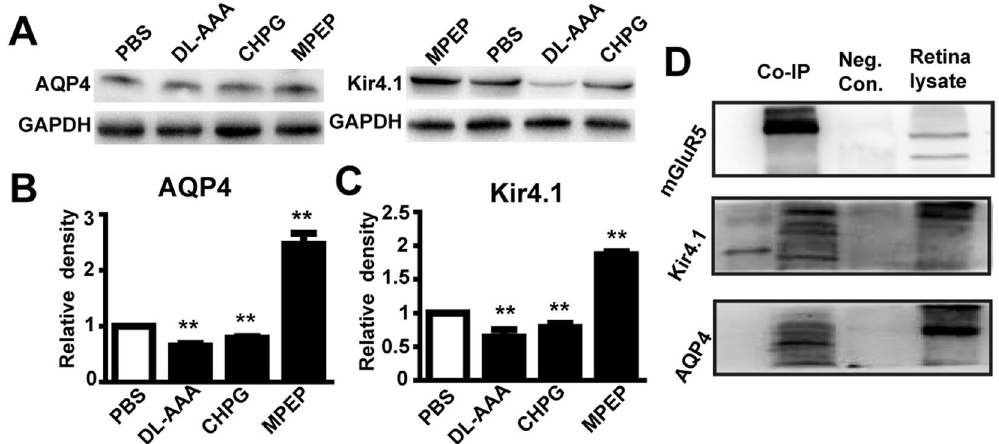
Figure 7. A macromolecular complex is formed by mGluR5, AQP4 and K ir 4.1. ( A ) Representative western blotting showing the expression of K ir 4.1 and AQP4 by retinas following the administration of DL-AAA, CHPG or MPEP, vs. PBS controls. GADPH is a loading control. ( B ) Quantification of AQP4 protein expression under the above conditions (n = 3 per bar). ( C ) The same as ( B ), but for K ir 4.1 expression (n = 3 per bar). ( D ) Representative immunoprecipitation assay for mGluR5, with subsequent immunoblotting for K ir 4.1 and AQP4. Neg. Con ., IgG negative control. Retinal lysate was used as a positive control. Bar charts show means ± SEM. ** p <